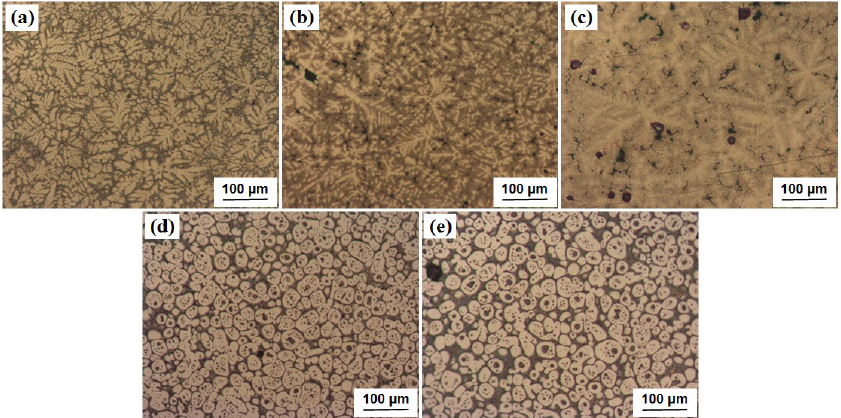
Figure 5. Optical micrographs of the microstructure of the deformed ZA27 alloy (a) when it is partial remelted for (b) 5 min, (c) 10 min, (d) 15 min, (e) 20 min at temperature of 460 °C and (d) 15